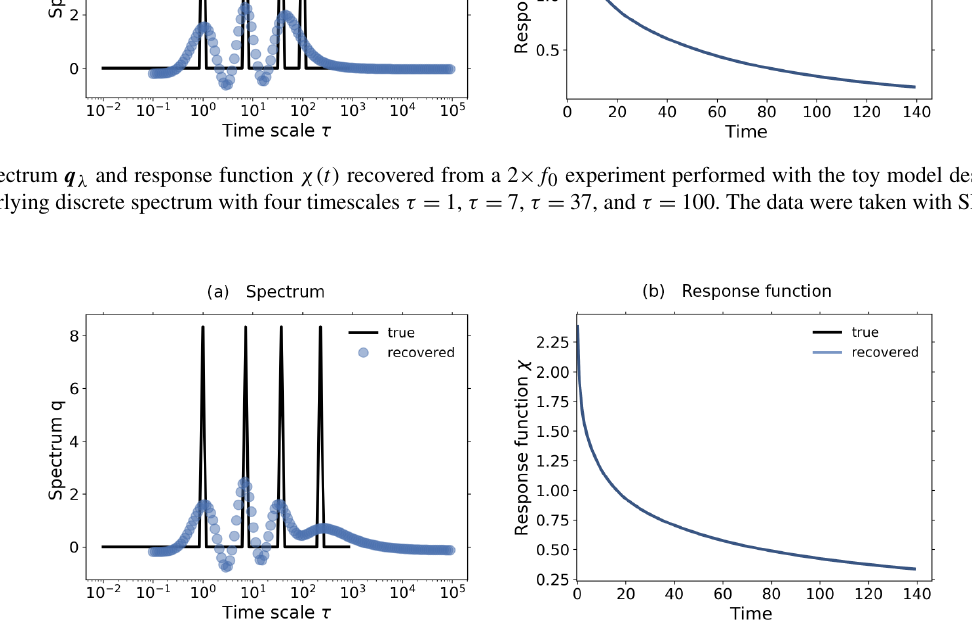
Figure E8. Spectrum q λ and response function χ(t) recovered from a 2 × f 0 experiment performed with the toy model described in Part 1 taking an underlying discrete spectrum with four timescales τ = 1, τ = 7, τ = 37, and τ = 228. The data were taken with SNR ∼ O ( 10 4 ) − O ( 10 5 )